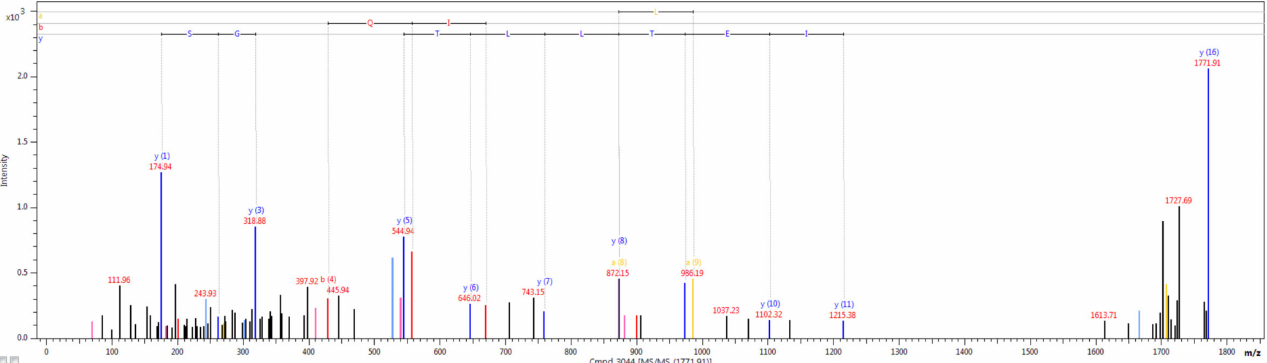
Figure 9. The representative example of the mass spectrum of m / z 1417.6834, identified as one of the COL1A2 peptides.